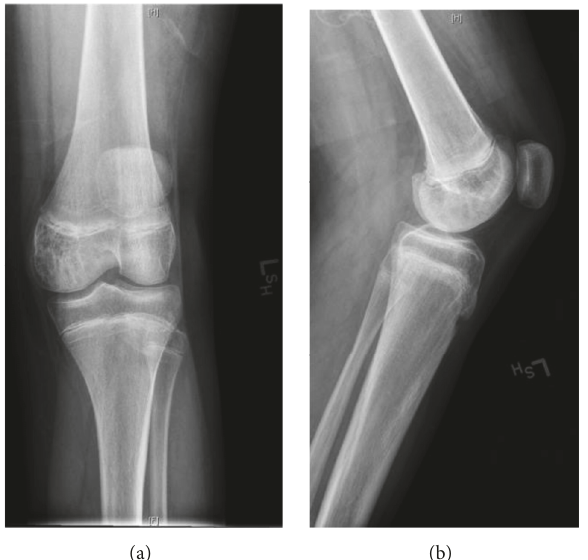
Figure 8: Anteroposterior (a) and lateral (b) radiographs of the left knee after chemotherapy, October 2010. Dramatic lesion response after treatment.